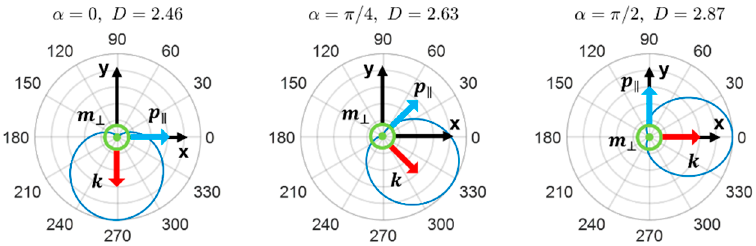
Figure 4. The far-field radiation pattern of the silicon nanodisk immersed in index-matching oil. The working wavelength is 633 nm. The polarization angles for v T ( α ) are (from left to right) α = 0, π /4, and π /2, respectively. The corresponding directivities are: 2.46 ( α = 0), 2.63 ( α = π /4), and 2.87 ( α = π /2), respectively.